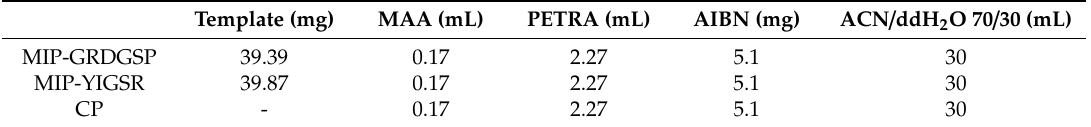
Table 1. Synthesis of molecularly imprinted particles. MIP: molecularly imprinted particles; CP: control particles. The template was GRGDSP for MIP-GRGDSP and YIGSR for